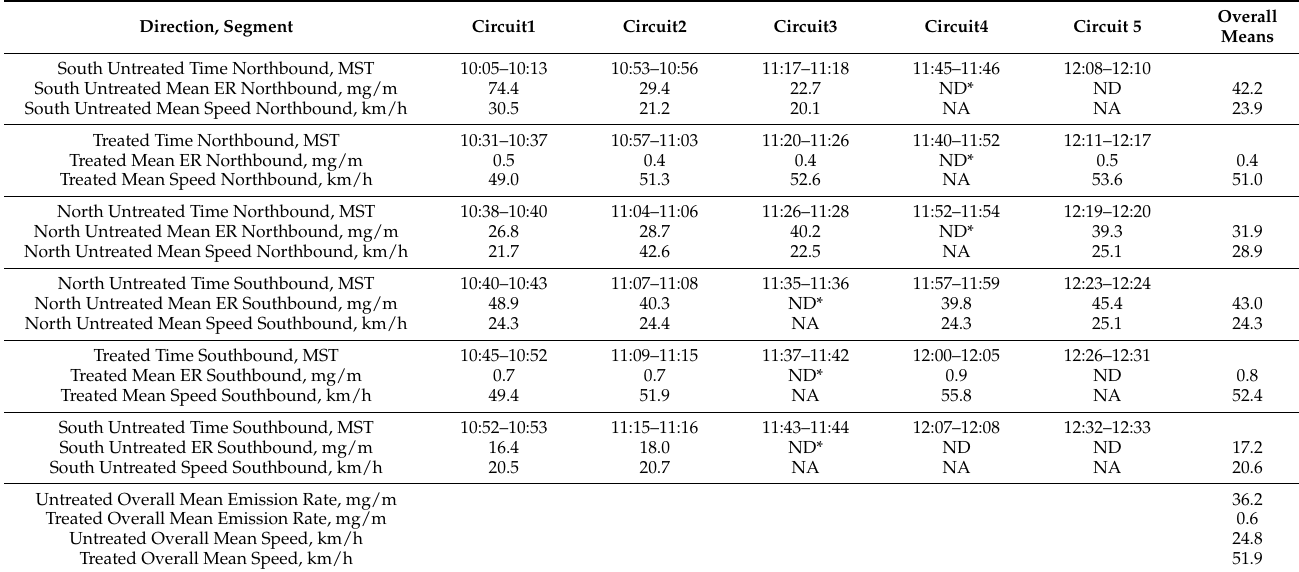
Table 2. Summary of mean PM 10 emission rates for the test route on SR 288. Circuit1 Circuit2 Circuit4 Circuit